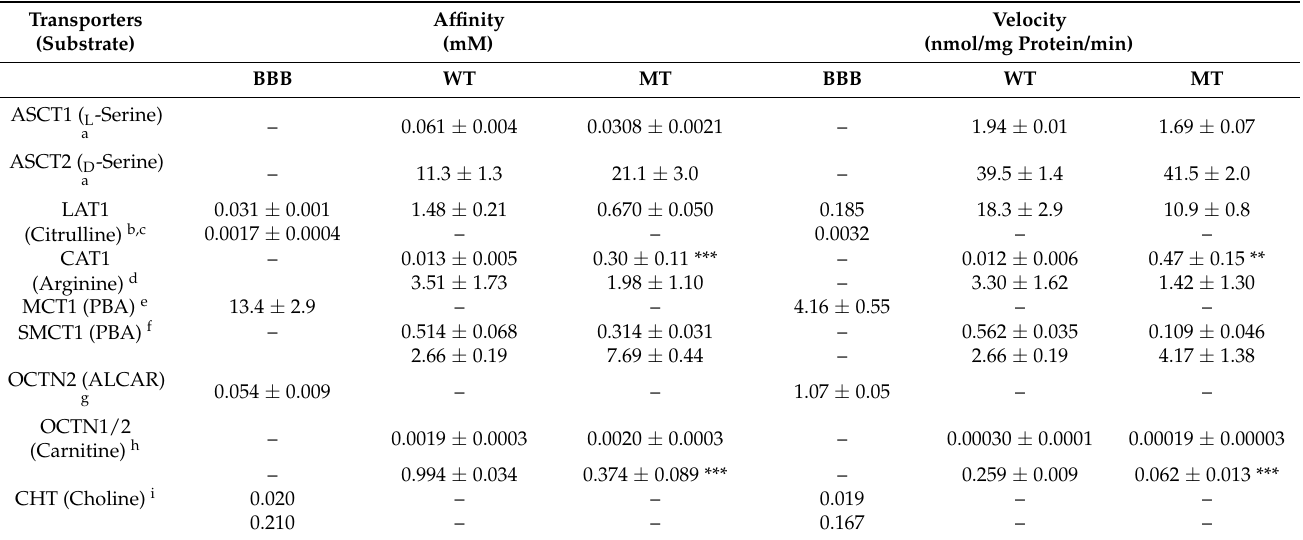
Table 1. Kinetic parameters analysis of various transporters in BBB and ALS model cell